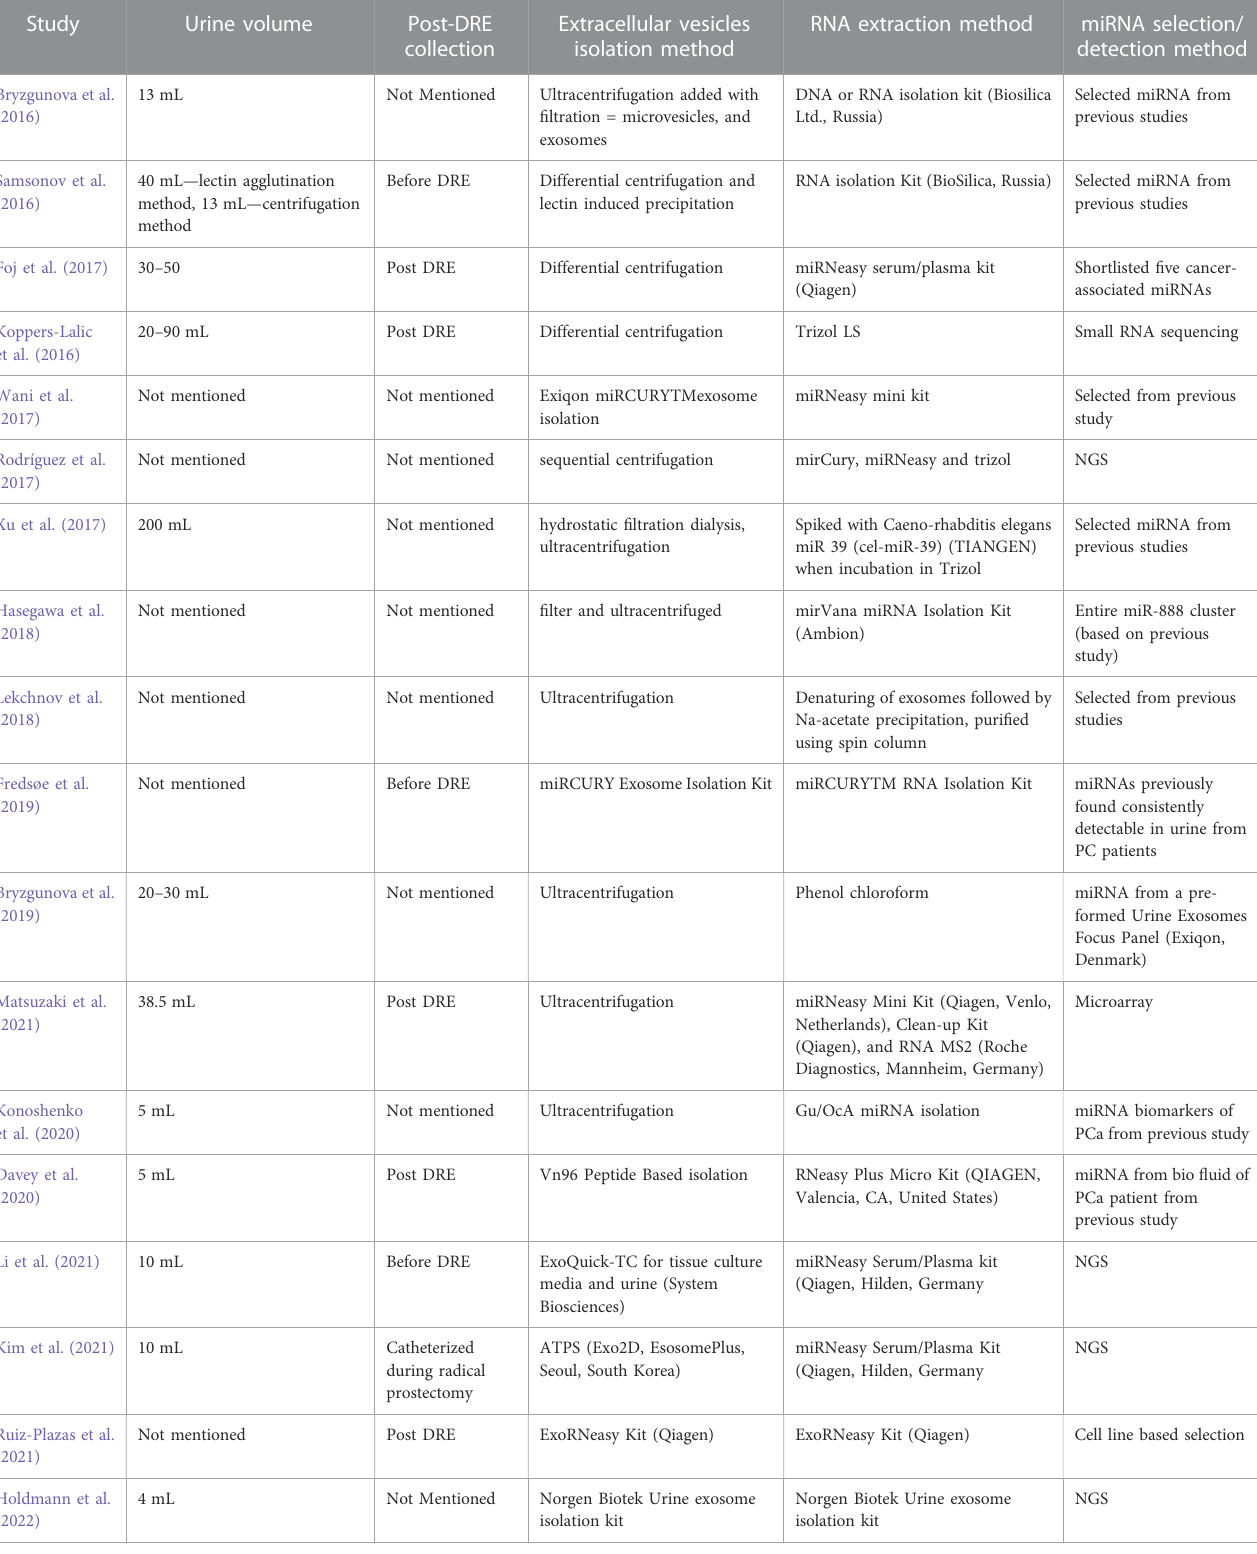
TABLE 3 Summary of studies involving the analysis of urinary-extracellular vesicle (EV) miRNAs that have been analyzed in this review including information on the urine volume used for the isolation of EV, the isolation method, the method used for EV miRNA extraction, and the approach followed to select the miRNAs of study.